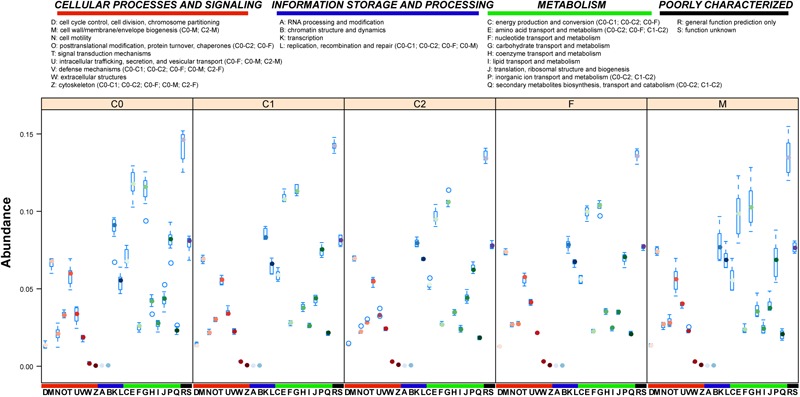
COG annotation of sample genes. COG functional annotation of gut microbial genes of investigated giant panda samples. The boxplot shows the gene abundance in COG functional classifications of samples by age. Significantly altered (Wilcoxon test, adjusted p < 0.05 by Holm method) COG classifications between age groups are shown in parentheses.